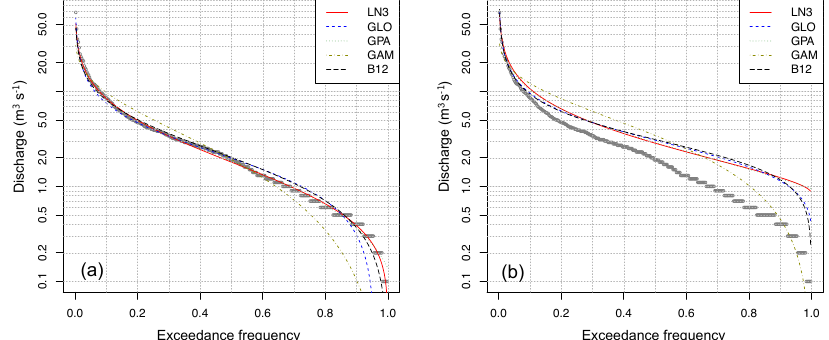
Figure 4. Empirical (points) and analytical (lines) flow duration curve for the Agogna at Momo river: (a) fitting on sample L -moments; (b) fitting on regional L -moments. Probability distributions are: log-Normal (LN3), Generalized Logistic (GLO), Generalized Pareto (GPA), Gamma (GAM) and Burr XII